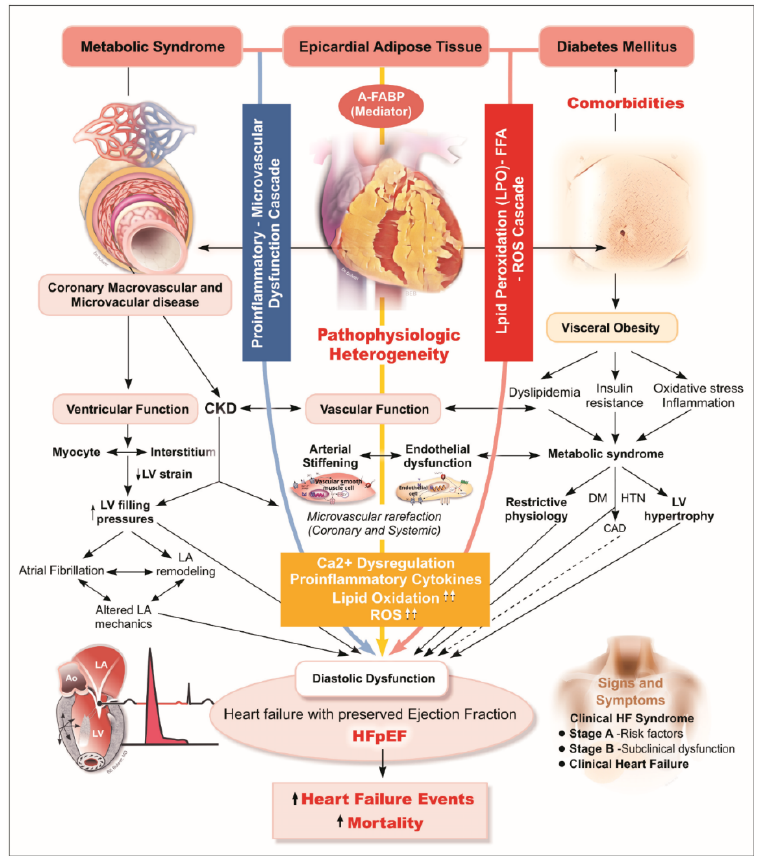
Figure 3. Diagram illustrating hypothetical pathological link between excecssive EAT, A-FABP, and HFpEF. In HFpEF, myocardial remodeling and diastolic dysfunction are driven by endothelial inflammation, a physical constriction effect limiting myocardial relaxation during diastolic phase caused by EAT, and EAT-related paracrine signaling/cytokines from oxidative stress and lipotoxicity (FFA hyper-influx). A-FABP, a main mediator enriched in and released from visceral adipose tissue, is believed to elicit downstream pro-inflammatory cascades, has been proposed as part of the “visceral adiposity syndrome”. Deteriorating microvascular/endothelial function accompanying diverse metabolic syndrome-related comorbidities and systemic pro-inflammatory signaling, leading to excessive extracellular matrix turnover/fibrosis, structural remodeling, impaired cardiac lusitropic/contractile properties with increased myocardial stiffness predisposing to HFpEF, and co-morbid renovascular dysfunction. A-FABP, adipocyte fatty acid-binding protein; HFpEF, heart failure with preserved ejection fraction.